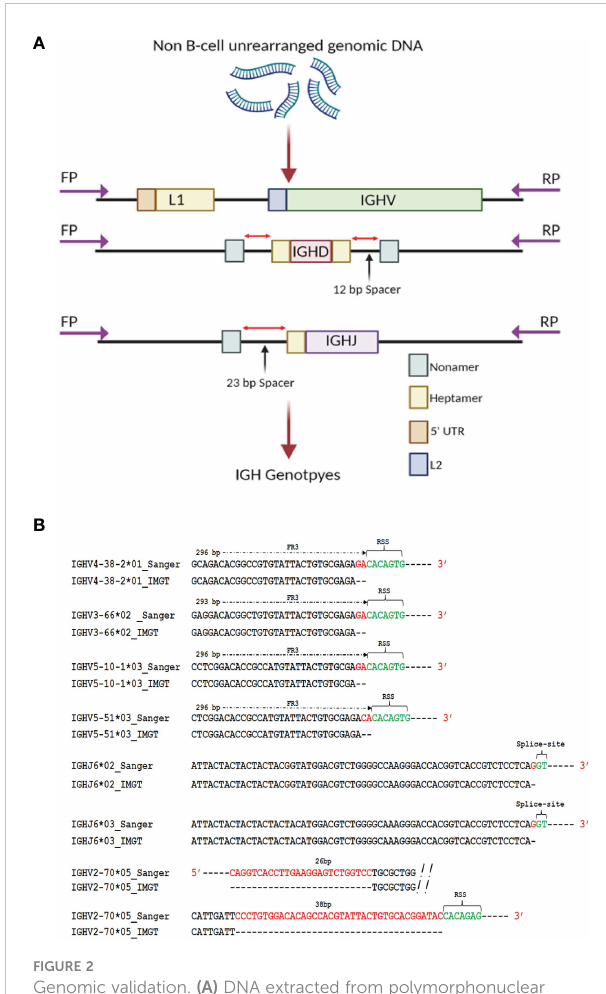
FIGURE 2 Genomic validation. (A) DNA extracted from polymorphonuclear cells from case D19 was used as template for individual PCR ampli fi cation of all IGHV, IGHD and IGHJ genes. Primers were located upstream of the leader coding sequence, and downstream of the RSS sequence in L2 V exon. Primers targeting the D genes were located upstream and downstream of the 5 ’ and 3 ’ D gene RSS segments respectively. Primers targeting the J gene were located upstream of the RSS segment and downstream of the J gene splice site segment. (B) Sequence discrepancies of known reference alleles identi fi ed through Sanger validation. Full length extension of truncated alleles IGHV3-66*02, IGHV4-38-2*01, IGHV2-70*05, IGHV5-10-1*03, IGHV5-51*03, IGHJ6*02 and IGHJ6*03 was enabled by the identi fi cation of the positions of framework 1,